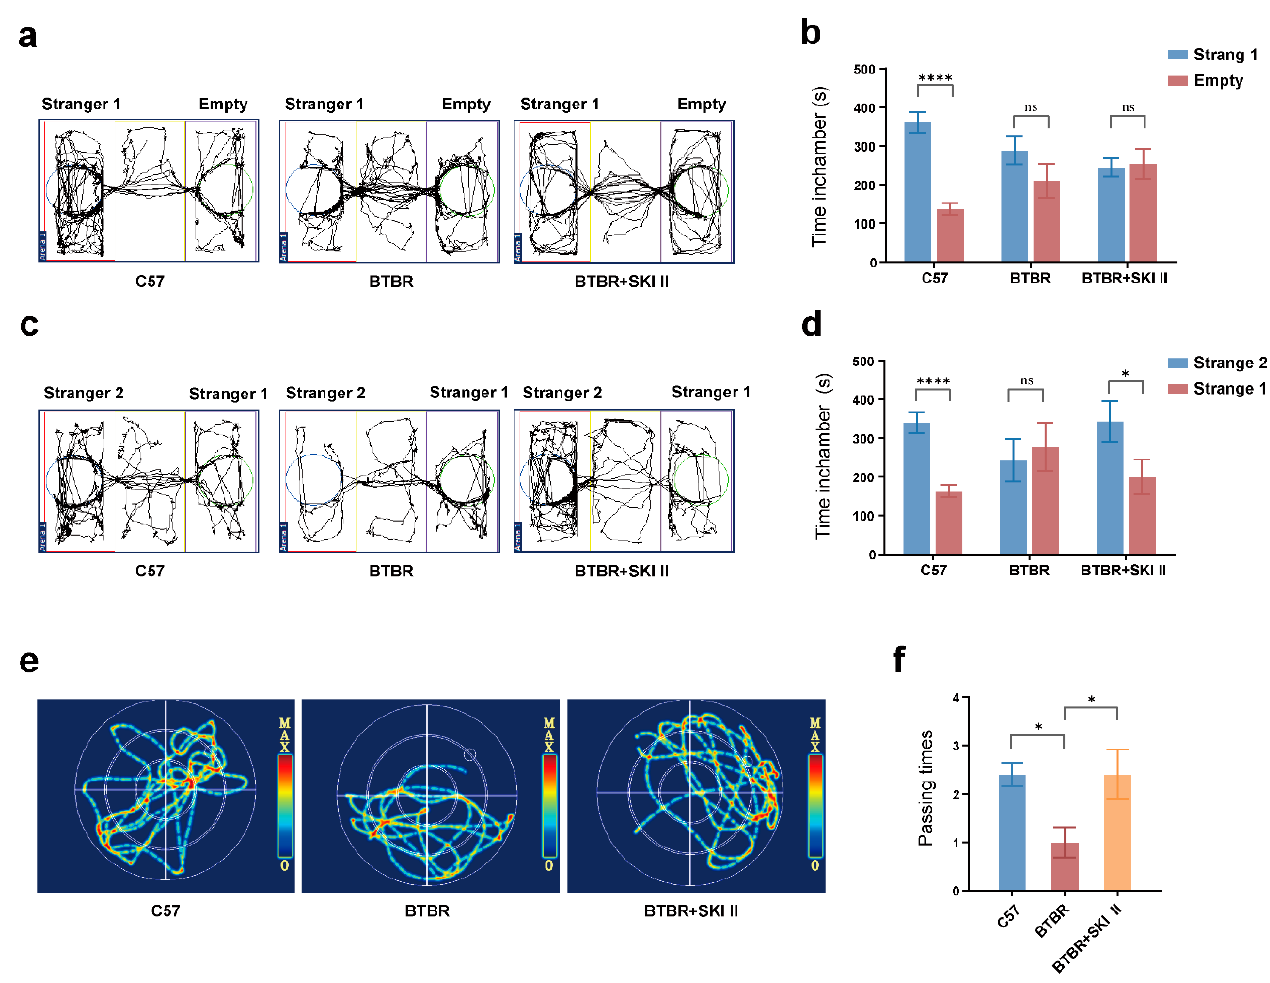
Figure 6. Blockade of ApoA-I-related pathways improved social ability, spatial learning and memory function in BTBR mice. ( a , b ) Representative roadmap and quantification of social preference in the three-chamber test. ( c , d ) Representative roadmap and quantification of social novelty in the three-chamber test. ( e , f ) Representative roadmap and number of target quadrant crossings (passing times) of the Morris water maze test. N = 12 per group. All data are shown in bar diagrams, which reflect the arithmetic mean ± standard error of the mean. * p < 0.05, **** p <